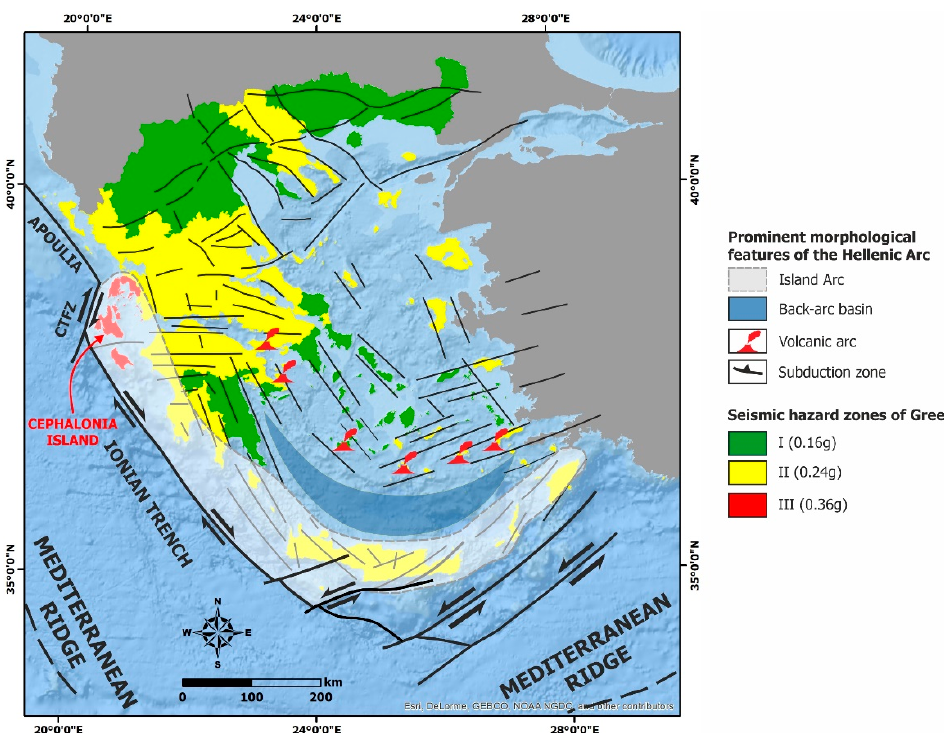
Figure 1. The Cephalonia Island is located at the northwestern part of the Hellenic Arc, east of the Cephalonia Transform Fault Zone (CTFZ). The island belongs to the zone III of the current Greek Building Code with a Peak Ground Acceleration (PGA) value of 0.36 g for a return period of 475 years [22].